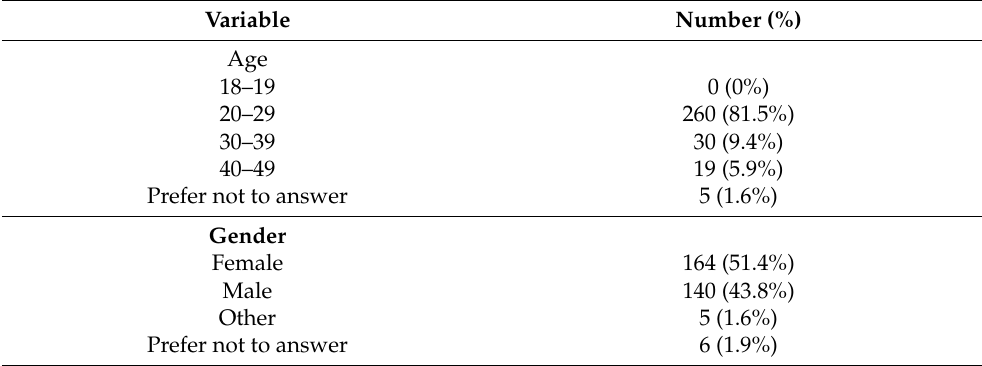
Table 1. Characteristics of Study Participants (N =